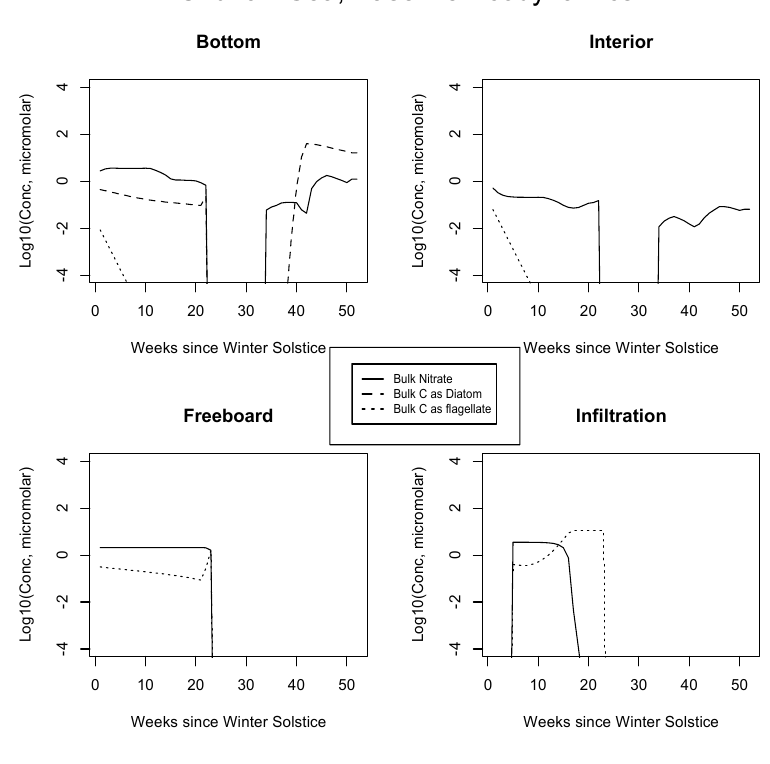
Figure 4. Chukchi Sea, caption as in Figure 3.